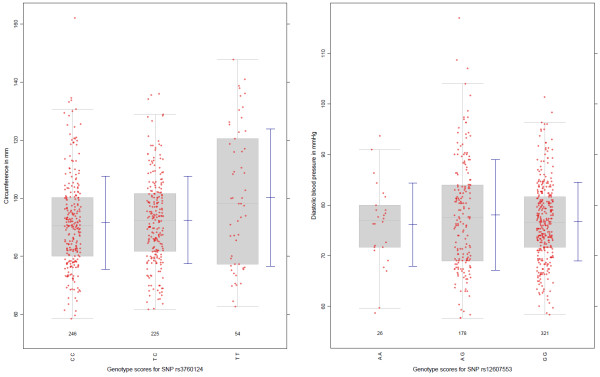
Boxplots including raw data for two selected SNPs and phenotypes of the Bogalusa Heart Study.